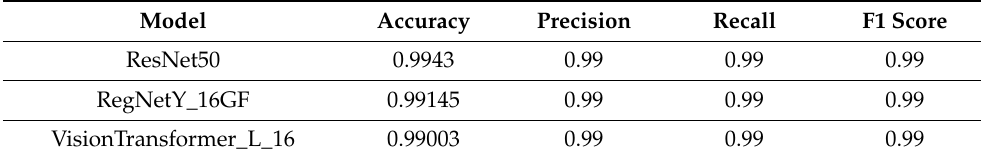
Table 7. Results for various models on DS-2 without CLAHE